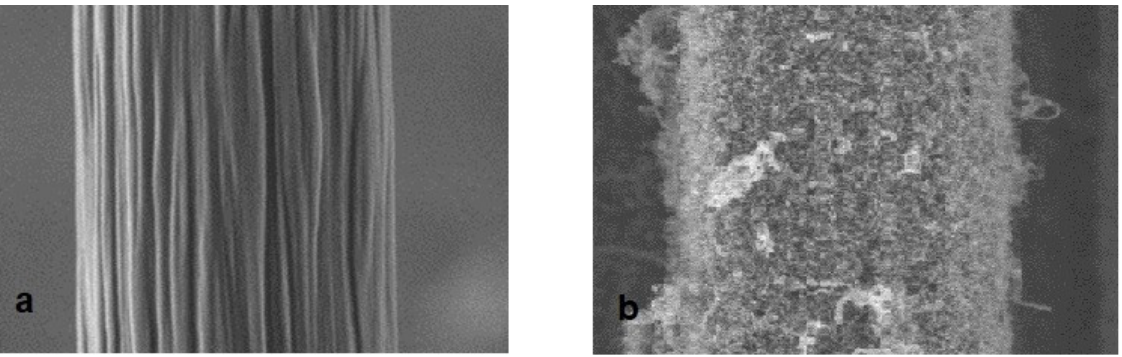
Figure 4. SEM image of 3 µm showing ( a ) acetone-treated CF, ( b ) CNT deposited CF via CVD [19].